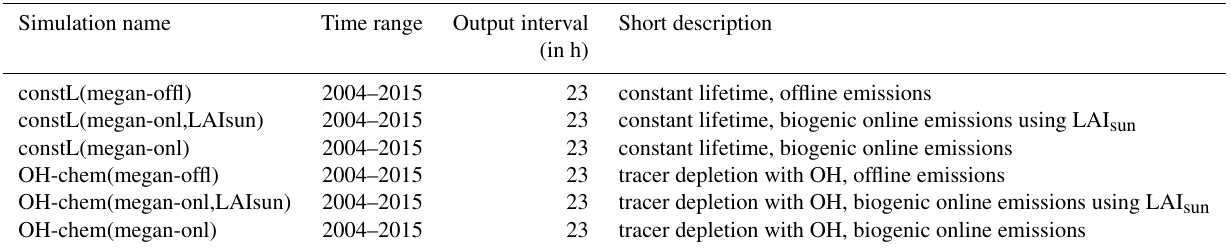
Table 6. Technical description of the simulations used in this study. For the emission inventories used see Table 3. Horizontal resolution for the simulations is R2B04 with an advective model time step of 460s. Output is given on model